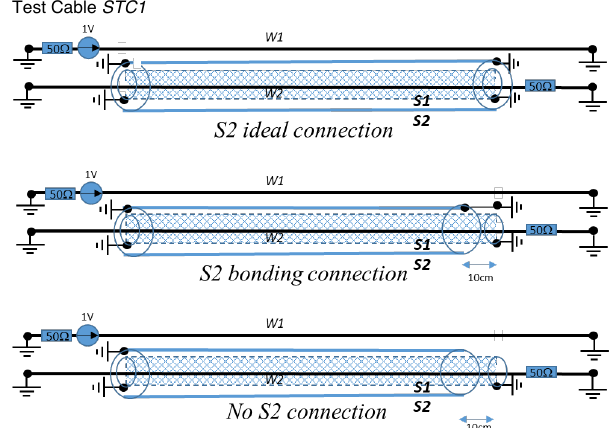
FIGURE 18. Electrical shield connections at the extremities for the Shielded Test Cable STC1